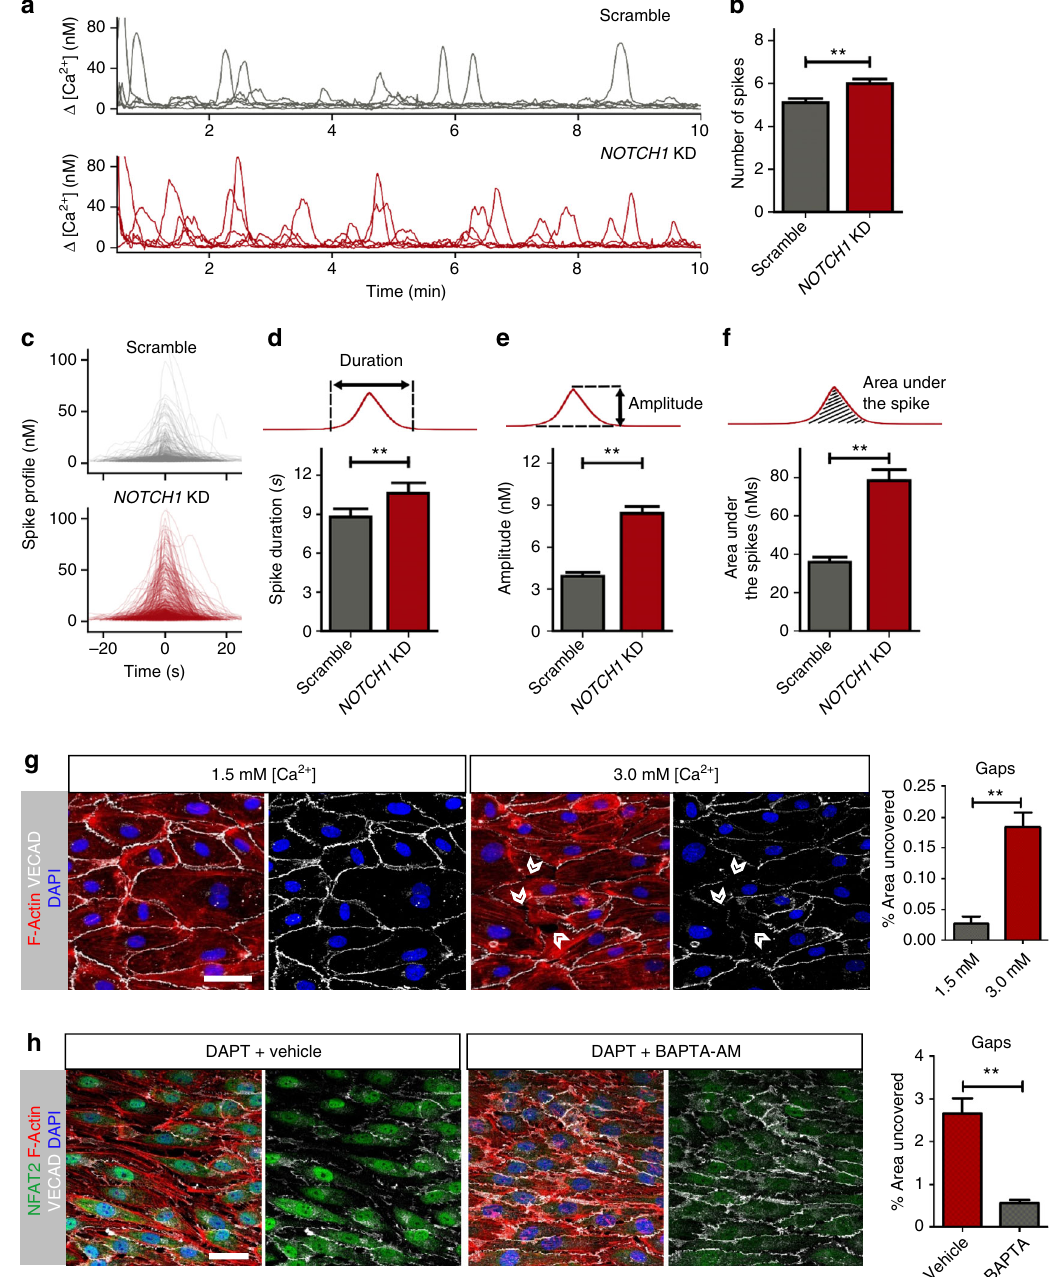
Fig. 7 Reduction in NOTCH1 increases Ca 2+ signaling under fl ow. a Typical examples of Ca 2+ responses using OGB-1-loaded HAECs after onset of fl ow at t = 0 for Scramble (top) and NOTCH1 KD (bottom). b – f Evaluations correspond to data from more than 300 cells in each condition: Scramble ( n = 347) and NOTCH1 KD ( n = 339) obtained from three independent biological replicates for each condition. Graph bars represent mean ± SEM. Signi fi cance was assessed by a Mann – Whitney U- test with ** P < 0.01. b Average number of spikes in each responding cell is greater for NOTCH1 KD compared to Scramble. c Average Ca 2+ spike plotted for each responding cell for Scramble and NOTCH1 KD. Peaks were aligned at t = 0 s. d Average Ca 2+ spike duration for each cell shows increased duration for NOTCH1 KD. e Average Ca 2+ spike amplitude was larger for NOTCH1 KD. f Average area under the spike for each cell was signi fi cantly larger for NOTCH1 KD cells compared to Scramble. g Monolayers of HAECs were cultured in normal media with physiological levels of [Ca 2+ ] (1.5 mM) or with CaCl 2 added to increase extracellular [Ca 2+ ] to 3 mM for 24 h under fl ow; scale bar = 20 µ m. Gaps (marked in white arrow heads) were only observed in the HAEC monolayers cultured with high extracellular [Ca 2+ ]. Gaps were quanti fi ed by measuring area uncovered to reveal an increase in gaps for monolayers cultured in higher extracellular [Ca 2+ ]. Graph bars represent mean ± SEM, n = 5. Signi fi cance was assessed by T- test ** P < 0.01. h HAECs were fl ow-conditioned for 24 h then treated with BAPTA-AM or vehicle and subsequently returned to fl ow for an additional hour in the presence of DAPT; scale bar = 20 µ m. Gaps were quanti fi ed by measuring the percent area uncovered to reveal that BAPTA treatment signi fi cantly improved junctional stability even in the absence of NOTCH1 signaling. For all imaging experiments, three biological replicates were used for each condition. Graph bars represent average ± SEM. Signi fi cance was assessed by T- test ** P <